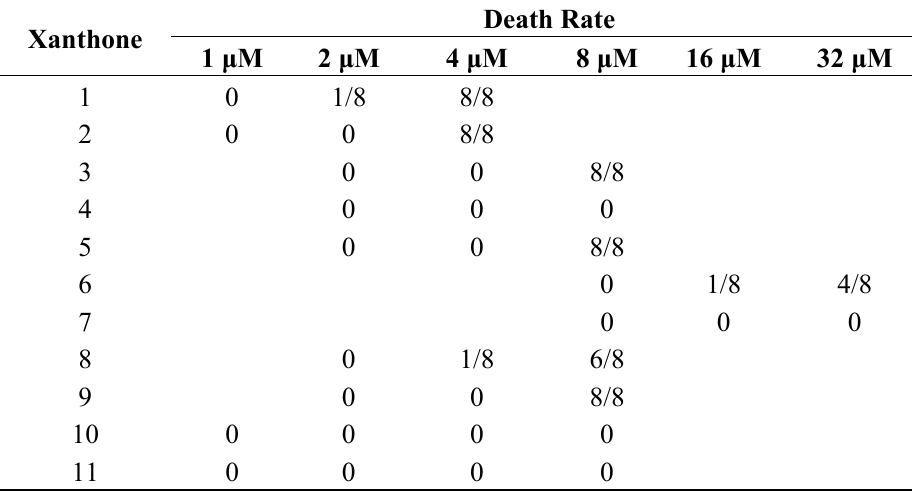
Table 3. Death rates of caged polyprenylated xanthones 1 – 11 in zebrafish embryos. Zebrafish embryos treated with embryo water were used as control and showed no death (0). The results shown are representative of three independent experiments.